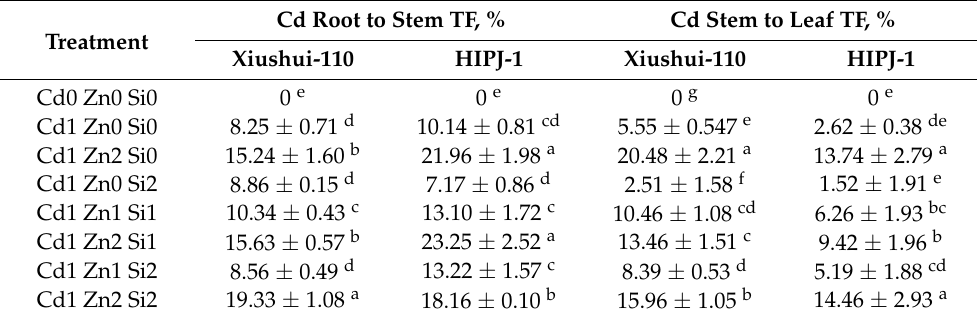
Table 3. Effect of alone and combined cadmium, zinc, and silicon application (30 d) on cadmium translocation factor for two rice genotypes. Cd Root to Stem TF, % Cd Stem to Leaf TF, % Treatment Xiushui-110 HIPJ-1 Xiushui-110 HIPJ-1 Cd0 Zn0